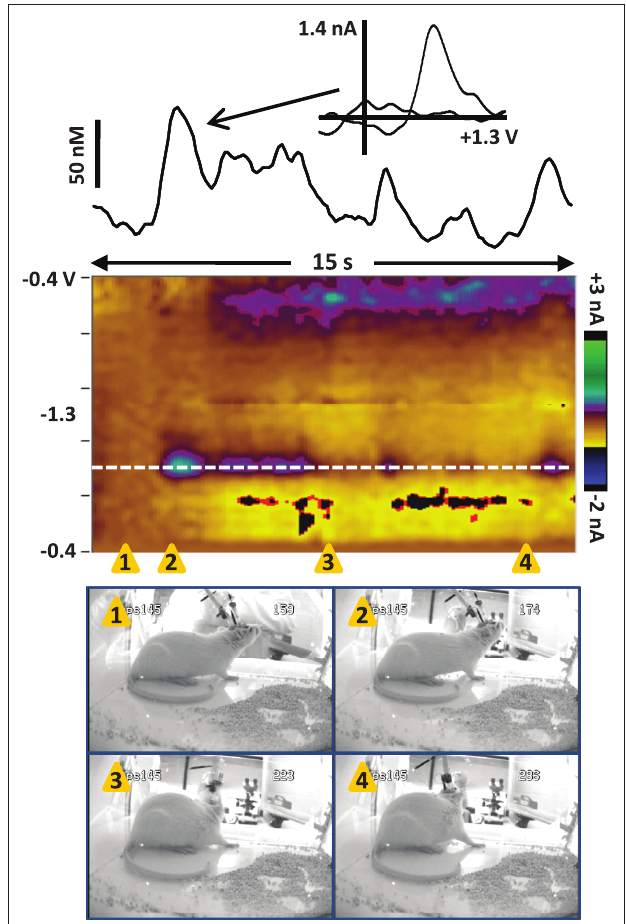
Figure 3 | Dopamine transients in the NAc core of a dam in the seconds before pup return (data also shown in Movie S1 in Supplementary Material). The color plot shows the changes in current at each applied potential over a 15-s window, and current at the oxidation potential of dopamine (white dotted line) is depicted in the line trace above the color plot. The timing of the snapshots is indicated by the orange triangles. In this sequence, the investigator has opened the door of the test chamber (snapshot 1) and is gathering pups to return to the dam (snapshots 2–4). The dam is positioned by the plexiglass front of the chamber, actively sniffing/ whisking and leaning in the direction of the investigator and the pups. Several dopamine transients occur while the dam is oriented toward the investigator and the pups. The transients are confirmed to be dopaminergic by evaluation of the cyclic voltammograms (inset